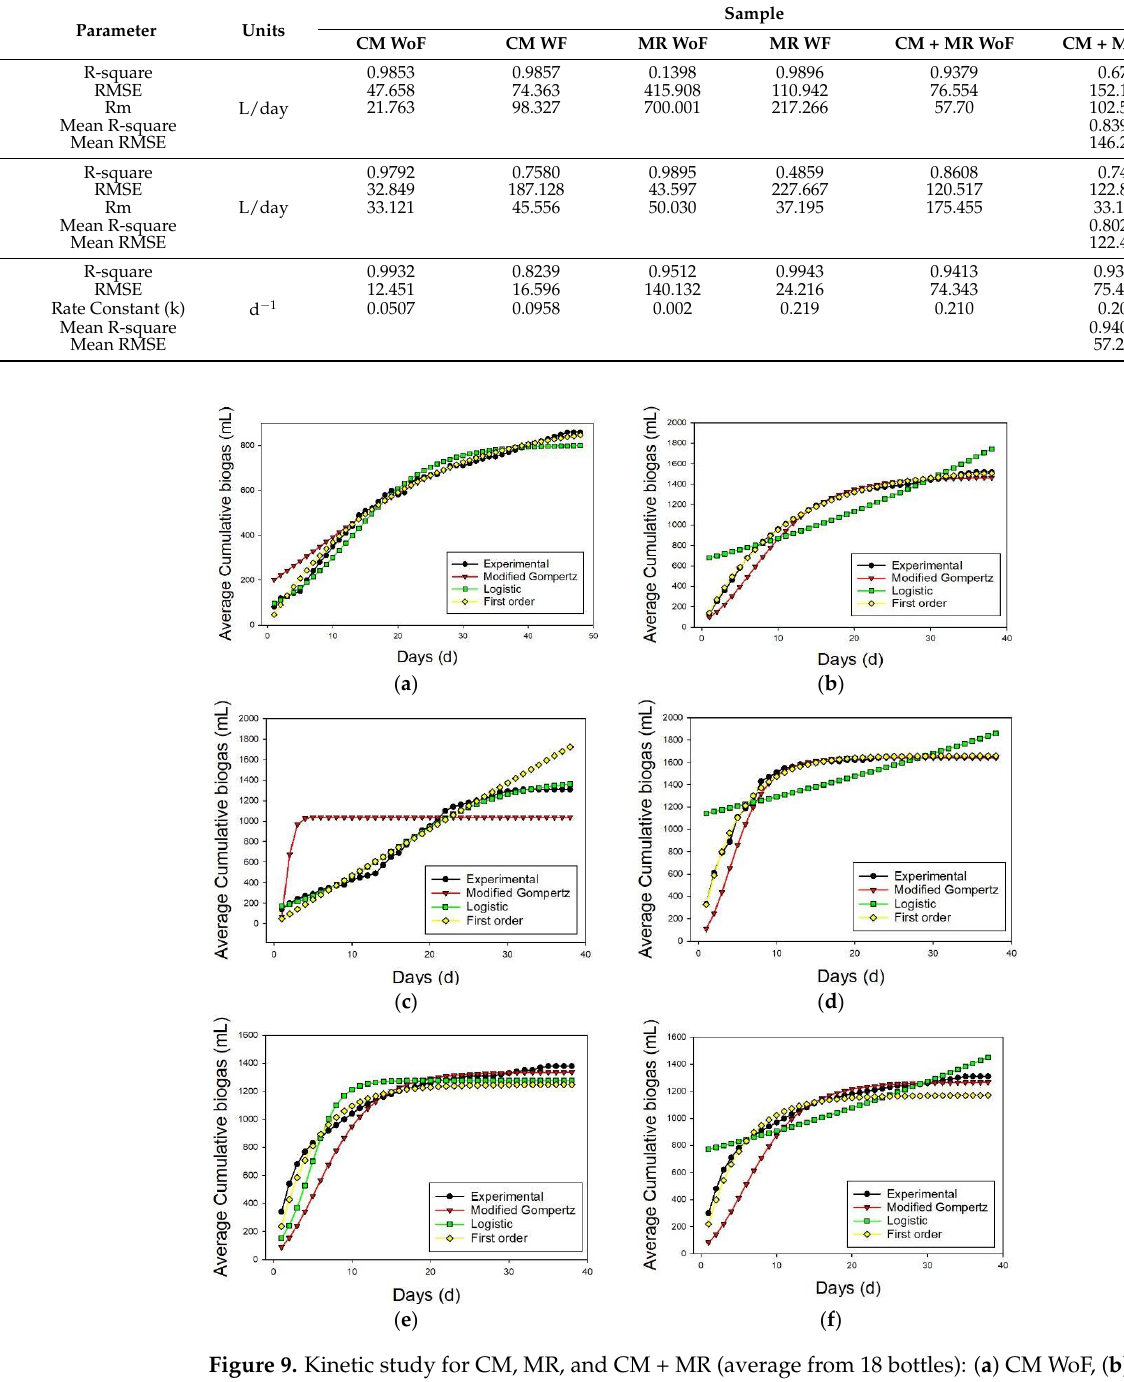
Table 9. Summary of kinetic analysis using different models.